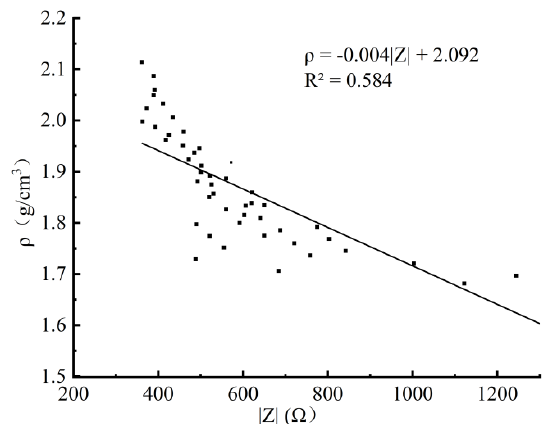
Figure 3. ρ – Z calibration equation (A1 group) .